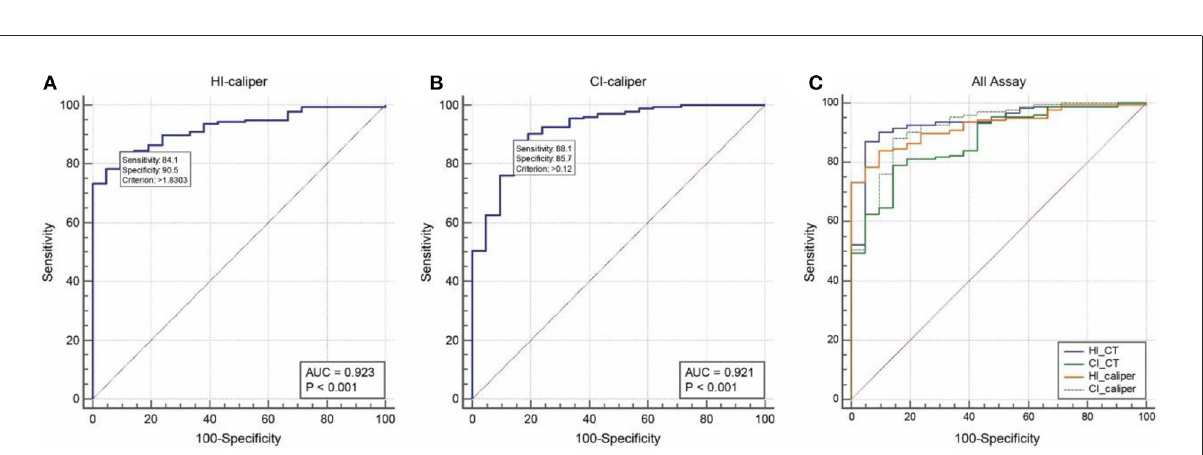
FIGURE4 Receiver-operator characteristic analysis. (A) The area under the curve (AUC) and optimal cut-off value of the HI-caliper were 0.923 (95%CI: 0.877–0.956, p < 0.001) and 1.83 (sensitivity = 0.841, specificity = 0.905), respectively. (B) The AUC and optimal cut-off value of the CI-caliper were 0.921 (95%CI: 0.874–0.955, p < 0.001) and 12% (sensitivity = 0.881, specificity = 0.857), respectively. (C) The AUC of HI-CT was 0.935 (95%CI: 0.891–0.965, p < 0.001), with a sensitivity of 0.894 and a specificity of 0.905 under HI-CT = 3.25. The AUC of CI-CT was 0.874 (95%CI: 0.820–0.917, p < 0.001), with a sensitivity of 0.625 and a specificity of 0.912 under CI-CT = 28%.